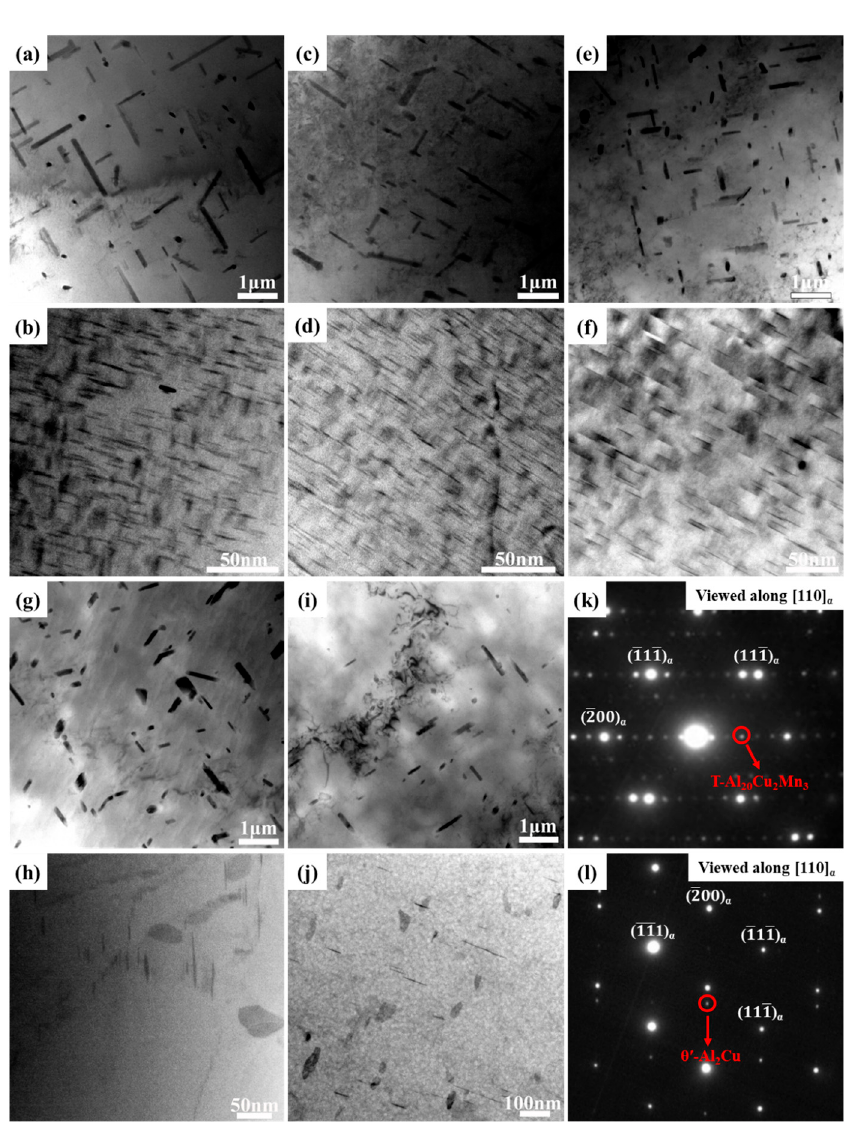
Figure 5. TEM images of nano-phases in heat-treated alloys: ( a , b ) 0 Ni alloy, ( c , d ) 0.5 Ni alloy, ( e , f ) 1.0 Ni alloy, ( g , h ) 2.0 Ni alloy, ( i , j ) 4.0 Ni alloy, ( k ) diffraction pattern of Al 20 Cu 2 Mn 3 viewed along [110] α -Al , ( l ) diffraction pattern of Al 2 Cu viewed along [110] α -Al , ( a , c , e , g , i ) microstructures of Al 20 Cu 2 Mn 3 , ( b , d , f , h , j ) microstructures of Al 2 Cu.